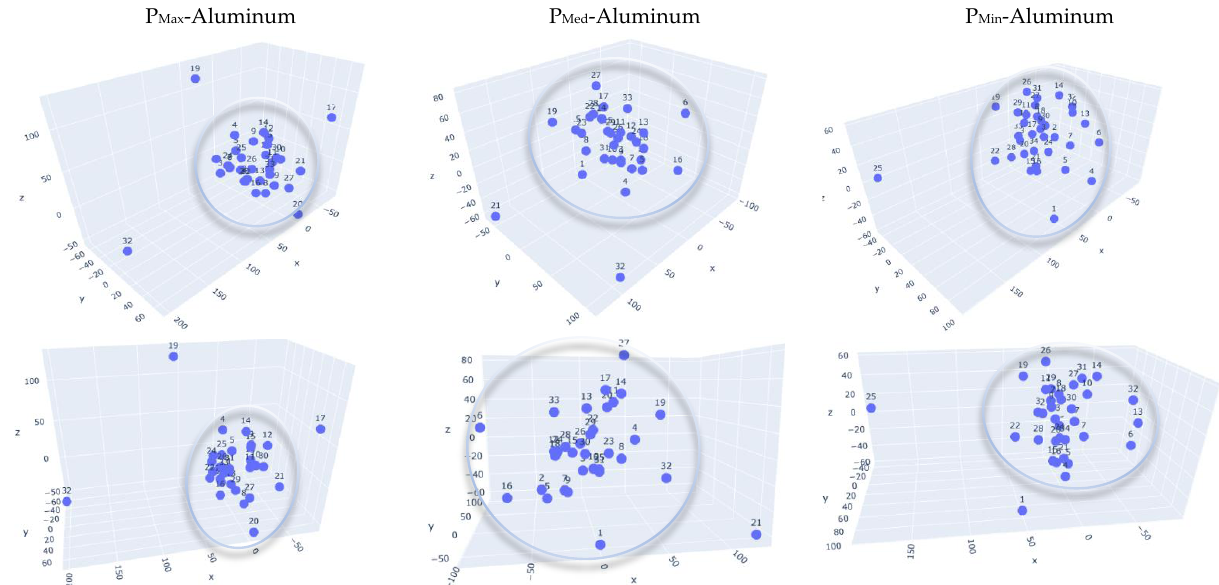
Figure A1. A series of differing perspectives for the PCA analysis of Figure 5b.